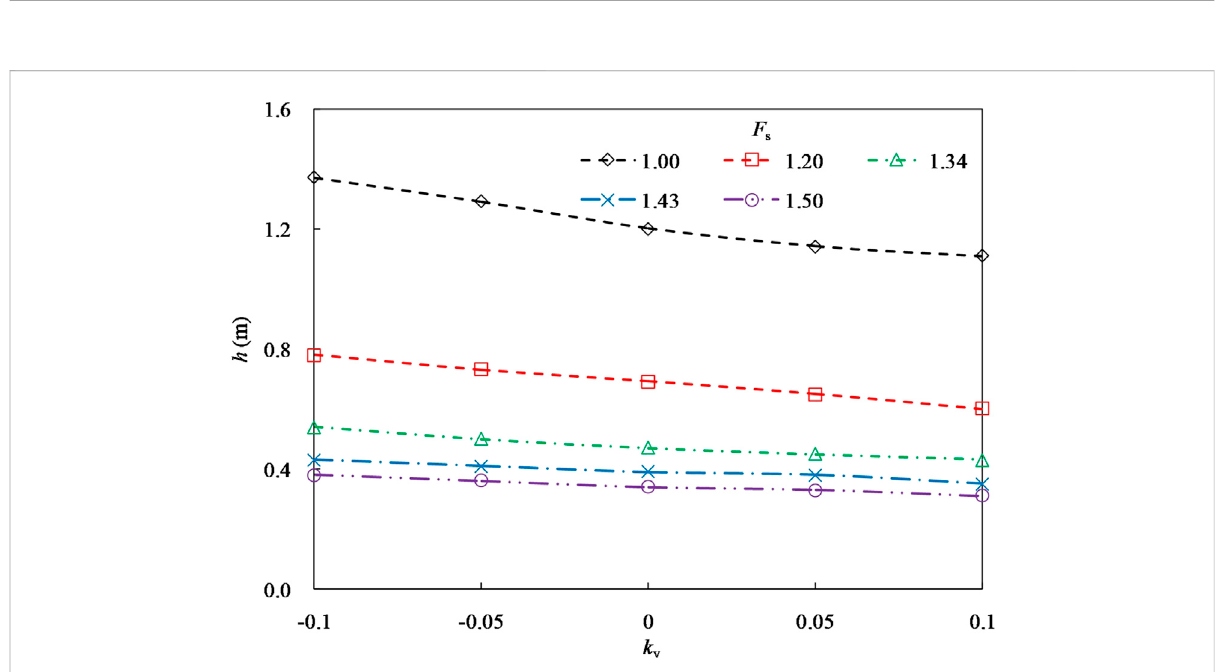
FIGURE 15 Relationship between h and k v under different F s